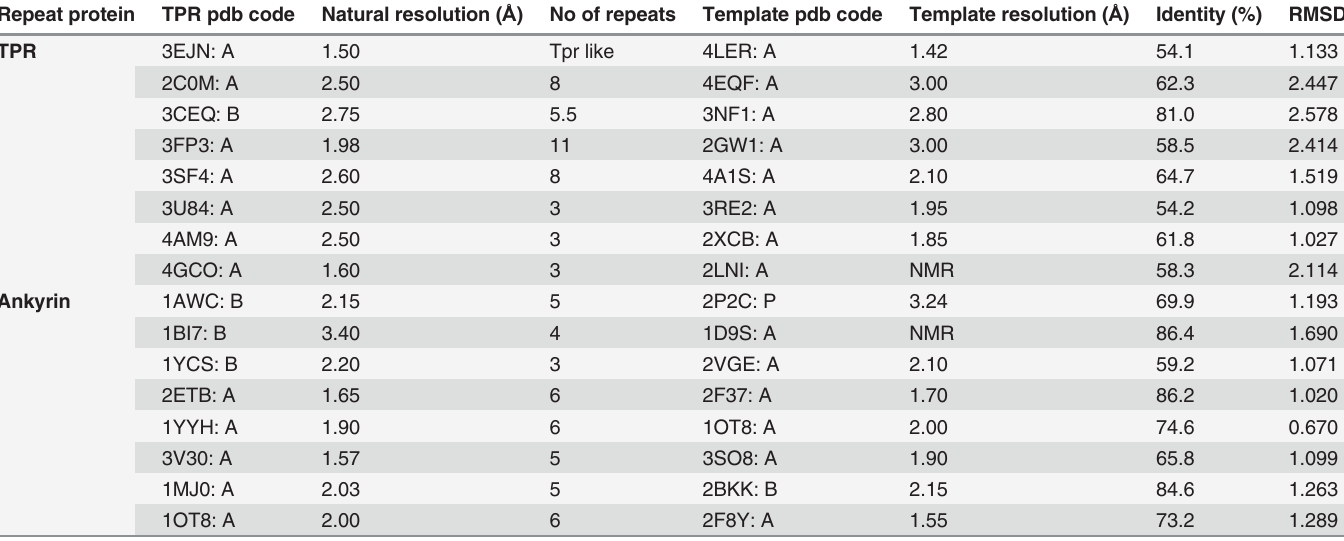
Table 1. Template proteins used in homology modeling of repeat proteins. Repeat protein TPR pdb